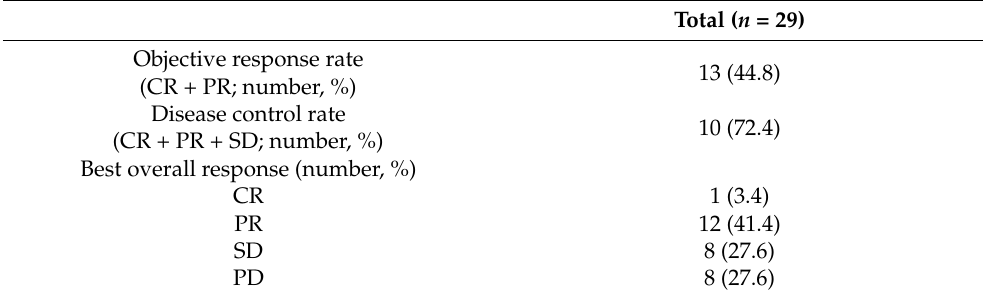
Table 3. Response to targeted therapy after discontinuation of nivolumab plus ipilimumab combina- tion therapy.